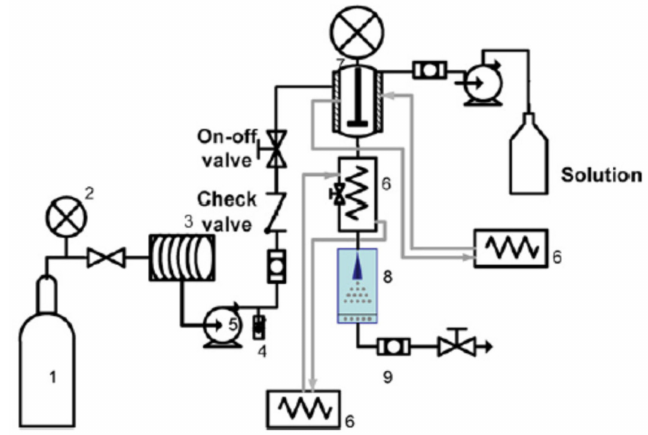
Figure 1. Schematic diagram of gas saturated solutions process (PGSS) technique: 1, CO 2 tank; 2, pressure gauge; 3, cooling bath; 4, safety valve; 5, pump; 6, heat exchanger; 7, high pressure vessel; 8, separator; 9, filter